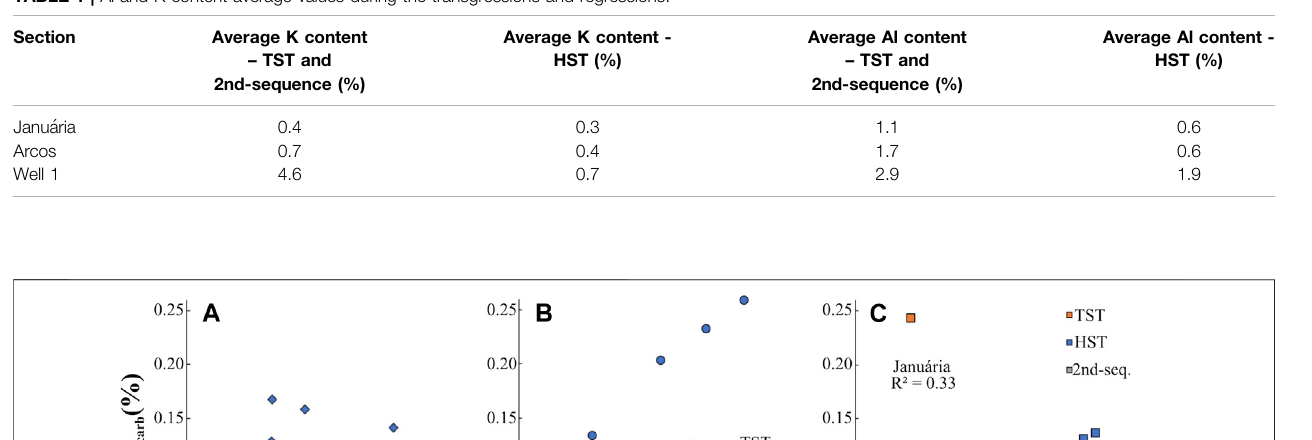
Frontiers in Earth Science |